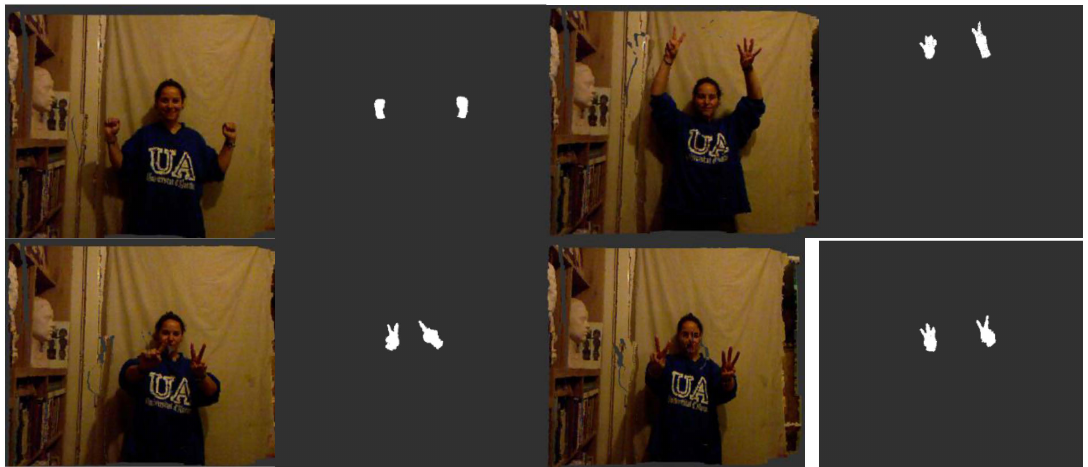
Figure 5. Visualisations of the original coloured point cloud and the final segmented hands of a user standing up.